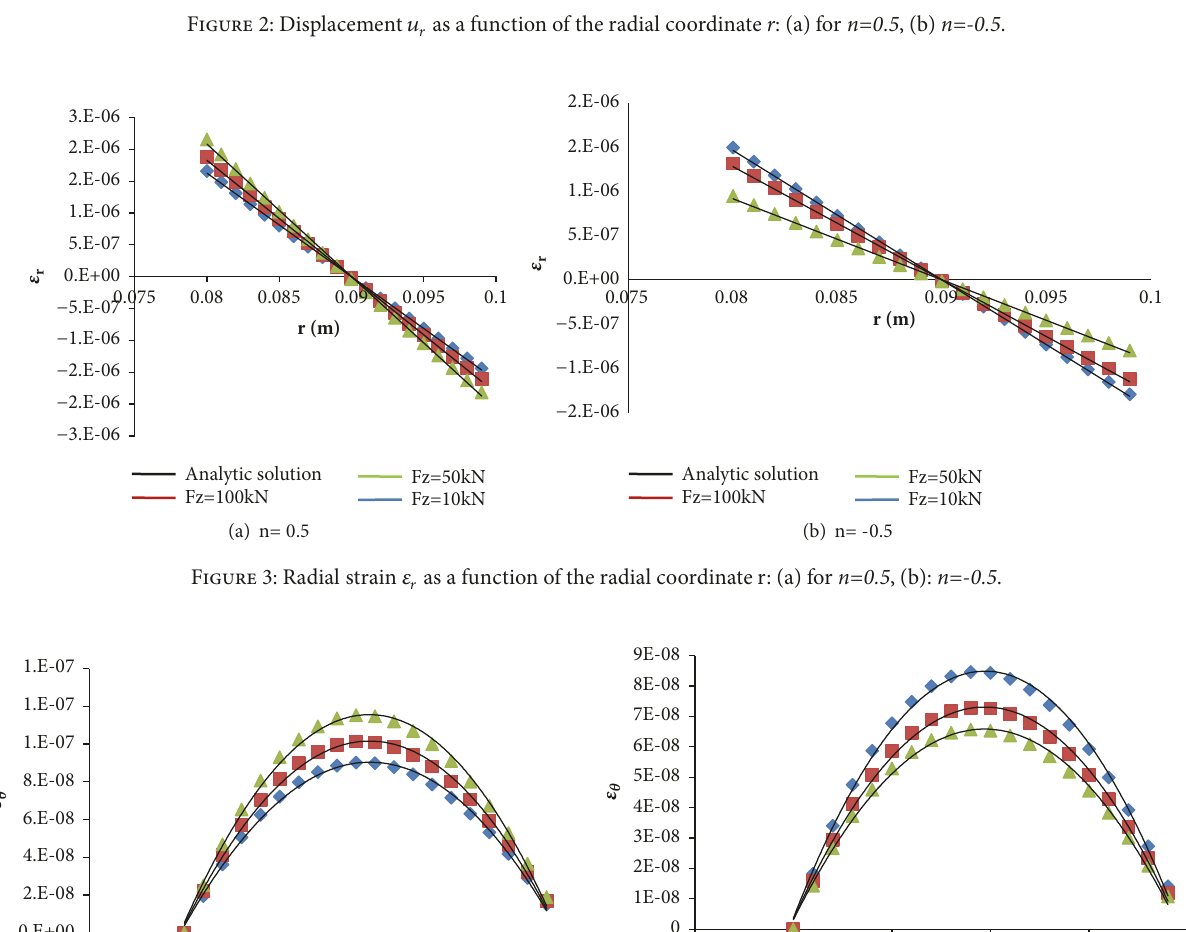
Fz=10kNFz=50kN Fz=100kNAnalytic